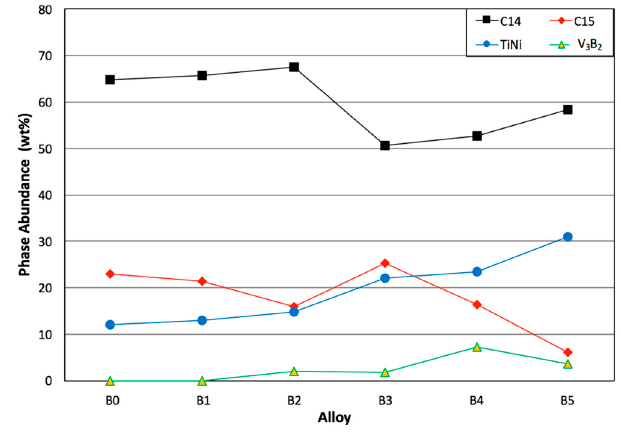
Figure 3. C14 unit cell volume change vs. boron content in the V-free [15] and V-containing AB 2 alloys. Figure 4. Evolutions of the C14, C15, TiNi, and V 3 B 2 phase abundances vs. alloy number.